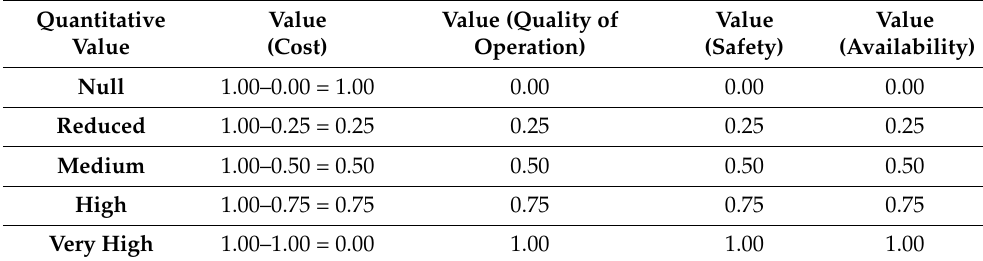
Table 6. Scale defined for the objective function